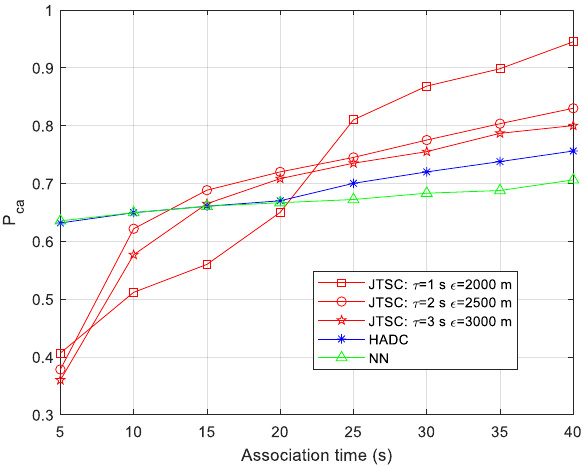
Figure 9. Probability. of correct association vs. different association times.